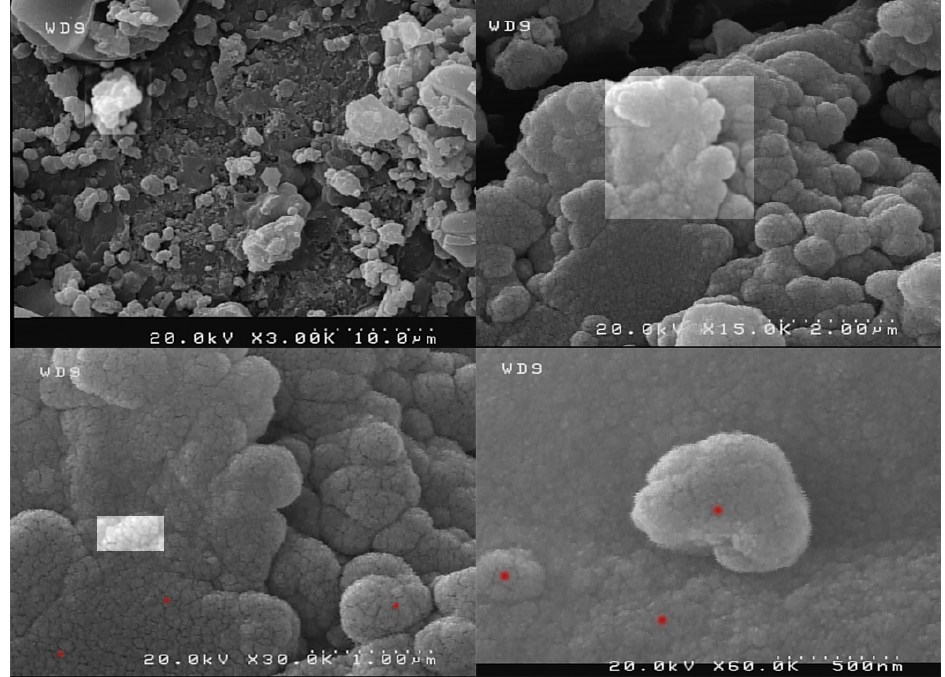
Figure 5. SEM image of nano-MIL-100. Extrapolation of SEM image showing magnification (from top-left to bottom-right). A number of nanoparticles are marked with red spots.